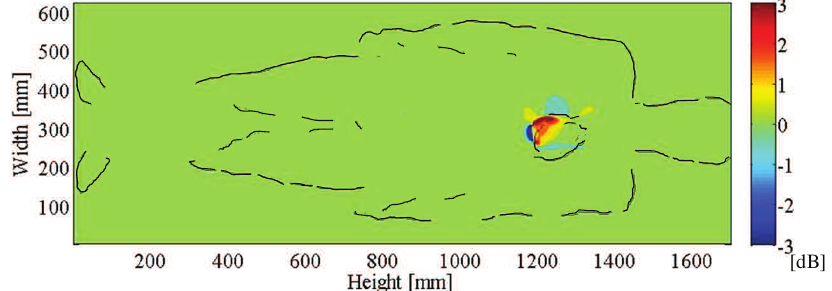
Figure 3. Distribution of difference of horizontal electric field strengths at a vertical plane behind the human body.